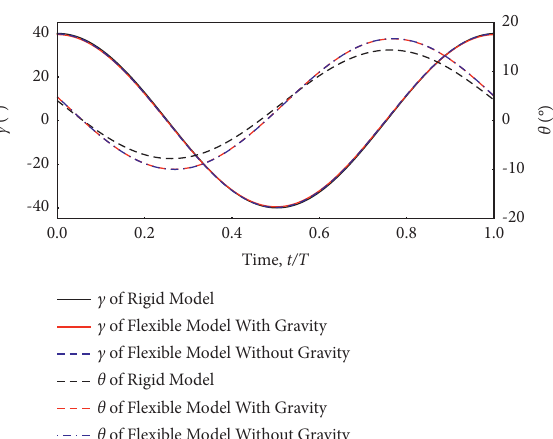
Figure 12: Degrees of flapping angle c and pitching angle θ varying with time in a period: (a) lift coefficient; (b) drag coefficient.